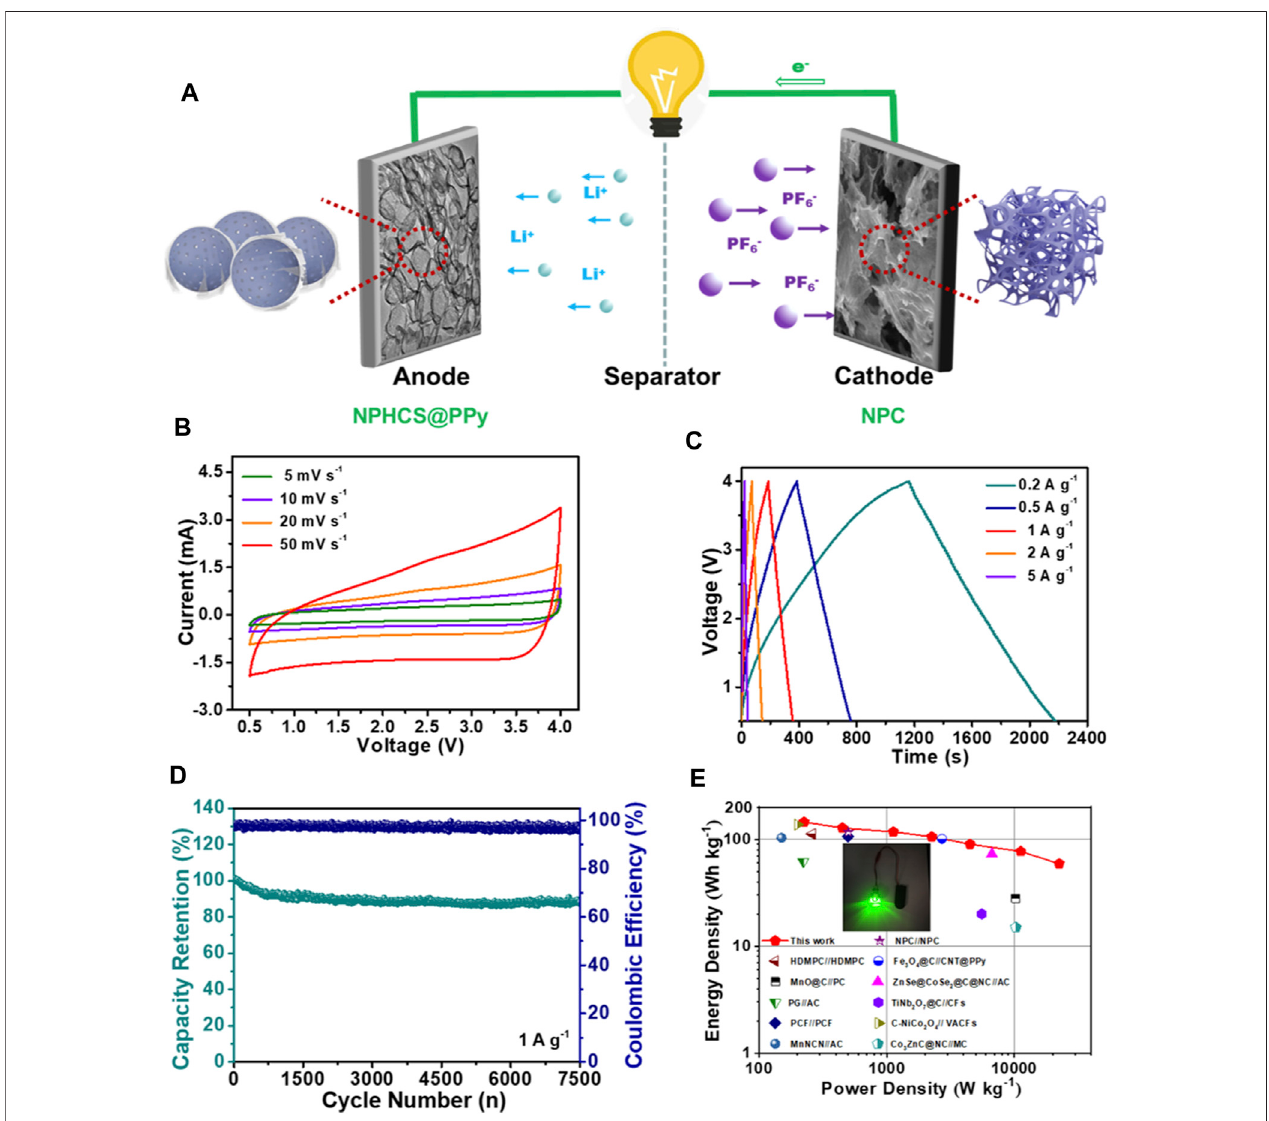
FIGURE4| ElectrochemicalperformancesofNPHCS@PPy//NPCLIC (A) Schematicillustrationofthechargeprocess (B) CVcurvesatvariousscanrates (C) GCD pro fi les at various current density (D) Cycling performance at a current density of 1 A g − 1 (E) Ragone plots in comparison with other reported LICs.